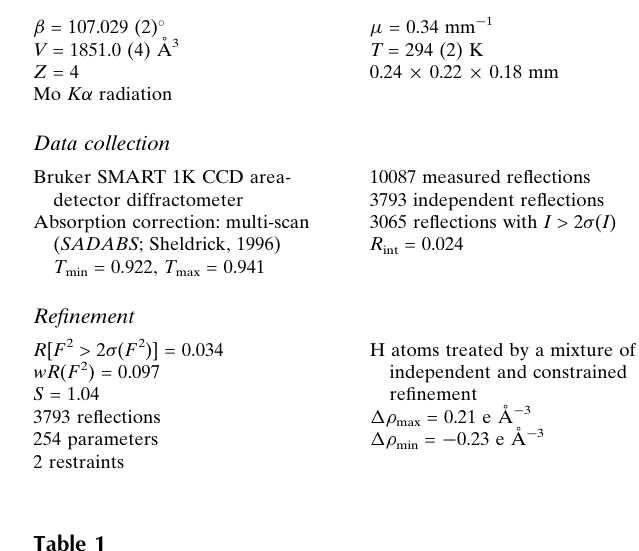
Hydrogen-bond geometry (A˚ , (cid:1) ). Cg 1 and Cg 2 are the centroids of the C1–C6 and C13–C18 rings, respectively. D —H (cid:2)(cid:2)(cid:2)